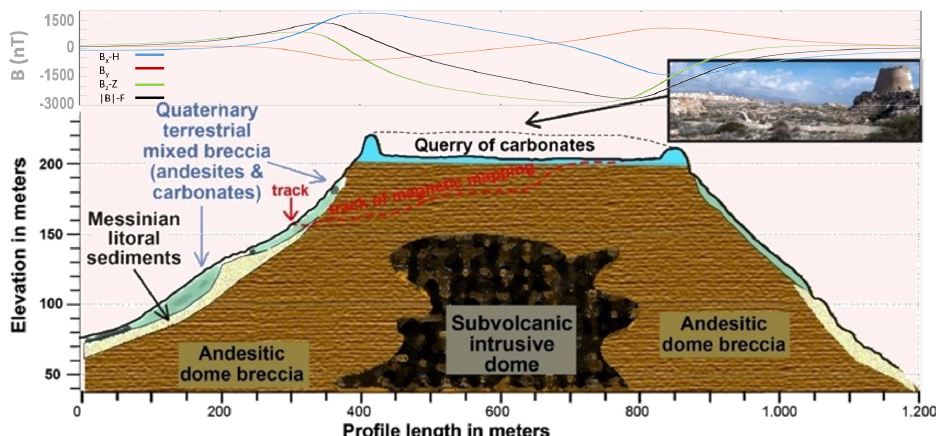
Figure 17. Interpretation of Mesa Roldán as a dome of 500 m diameter and 300 m height centered at the surface. Synthetic magnetic field: components and total field.